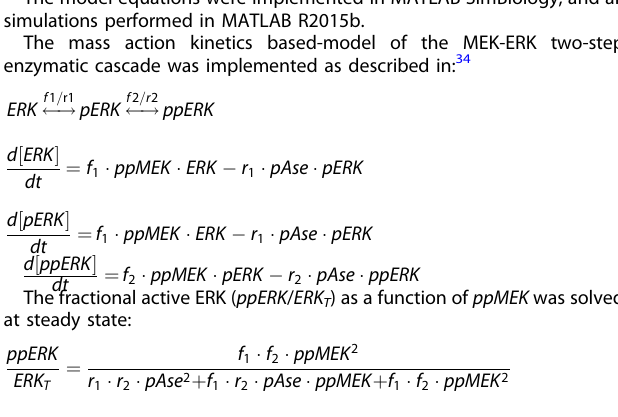
Table 3, and 1000 randomized parameter sets given in Table